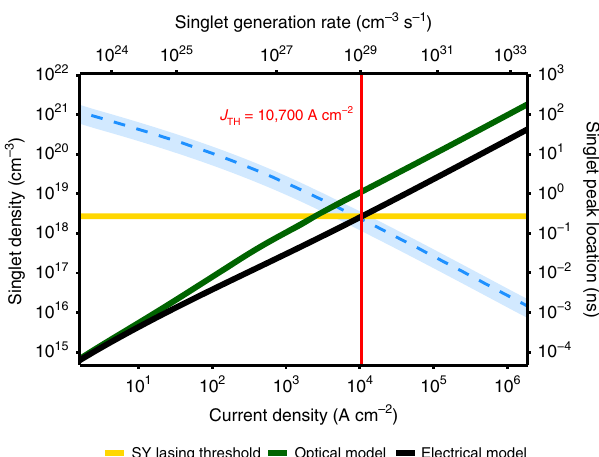
Fig. 4 Maximum singlet density as a function of pumping current density. Singlet concentrations obtained from the optical (green) and electrical (black) models are shown. Dashed blue line indicates time after pulse onset, at which the maximum was achieved. SY lasing threshold (yellow) expressed in singlet density and corresponding current density threshold (red) included for